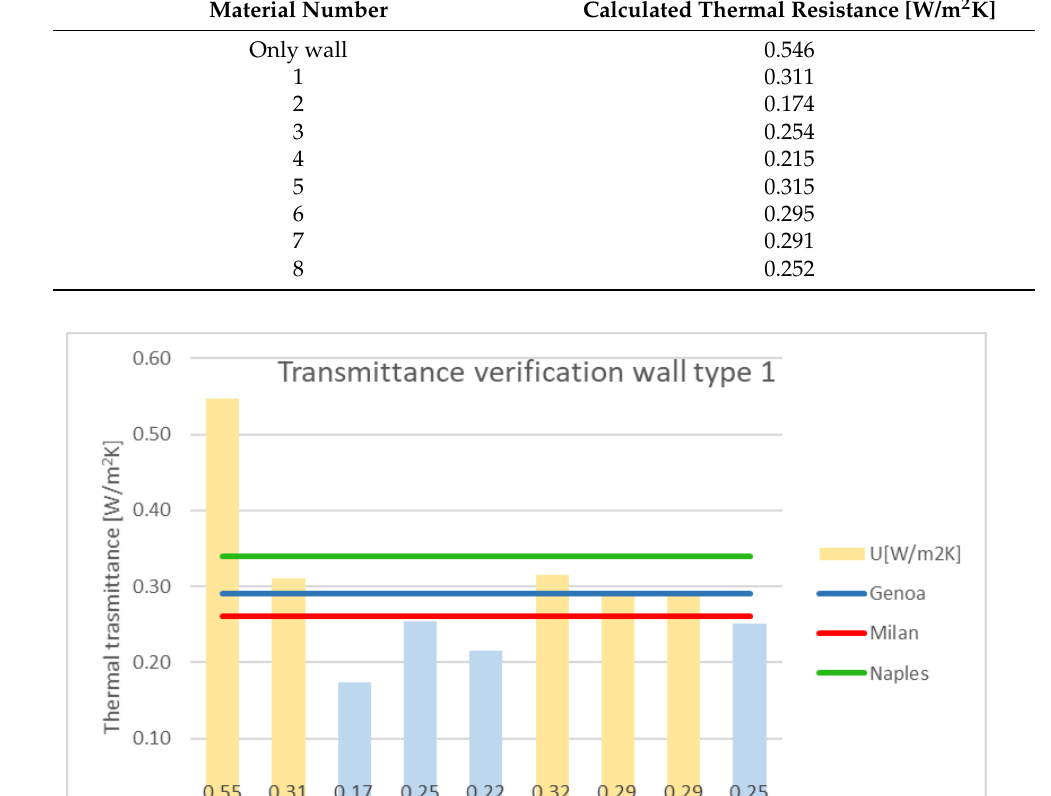
Figure A3. Wall type 2: stratigraphy with thicknesses and conductivities for the different layers. The numbers start from the outside.